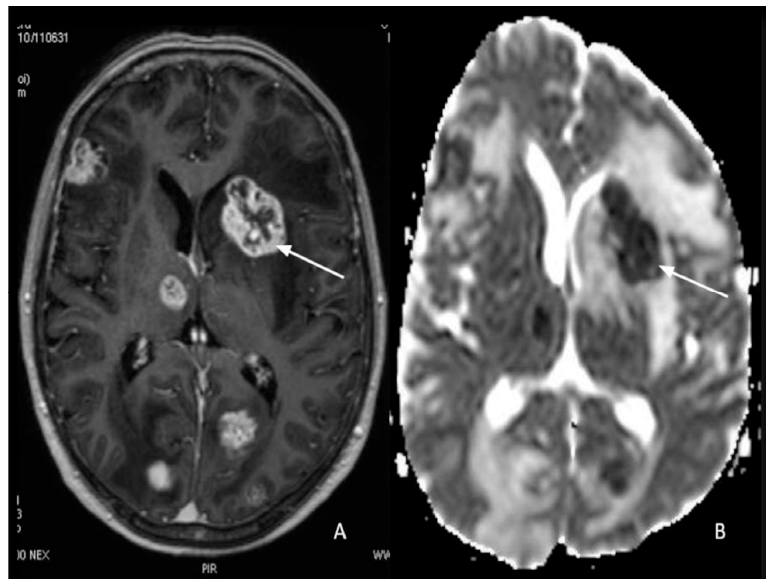
Figure 6. ( A ) Multiple enhancing metastatic lesions in a patient with lung cancer; ( B ) the reduced diffusion effect (arrow) is related to the high content of mucinous components.